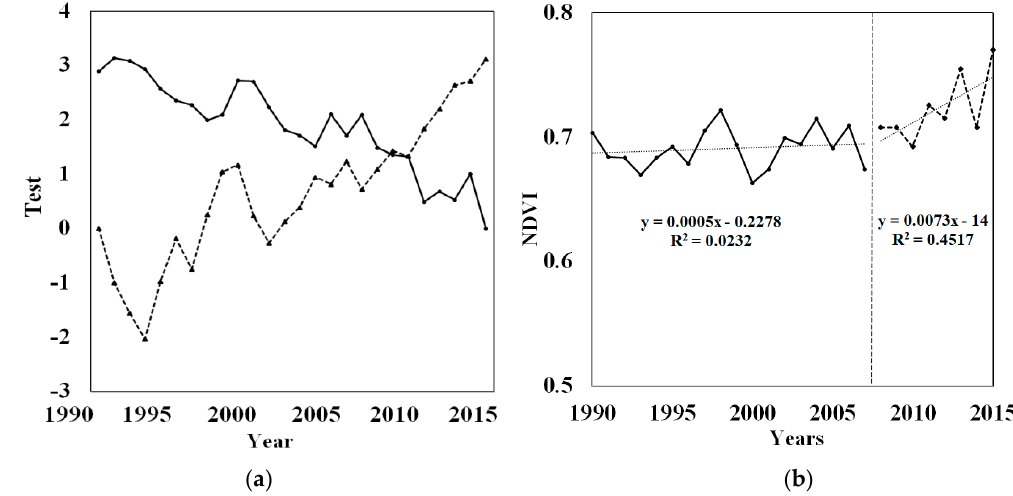
Figure 5. The changes in annual normalized difference vegetation index (NDVI) from 1990 to 2015: ( a ) Abrupt changes in the annual NDVI from 1990 to 2015 derived from the Mann–Kendall Trend Test Model test statistics, where the year of the intersection is the potential turning point; ( b ) Variation in the annual NDVI and linear trends for the two periods.